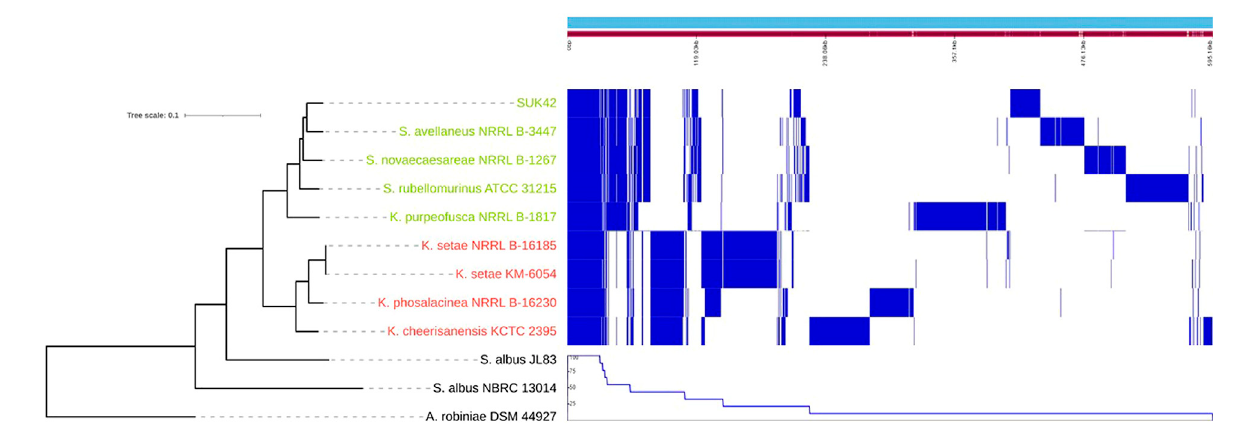
FIGURE 4 | Core and pan genome of Kitasatospora sp. SUK42 and other putative Kitasatospora reference sequences. Phylogenetic tree, core, shell, cloud and pan-genomes of Kitasatospora sp. SUK42 and the other eight putative Kitasatospora reference sequences ( Supplementary Table S1 ) were determined using Roary (Page et al., 2015) and displayed using Phandango (Had fi eld et al., 2018). Group 1 Kitasatospora strains are shown in green and Group 2 in red.